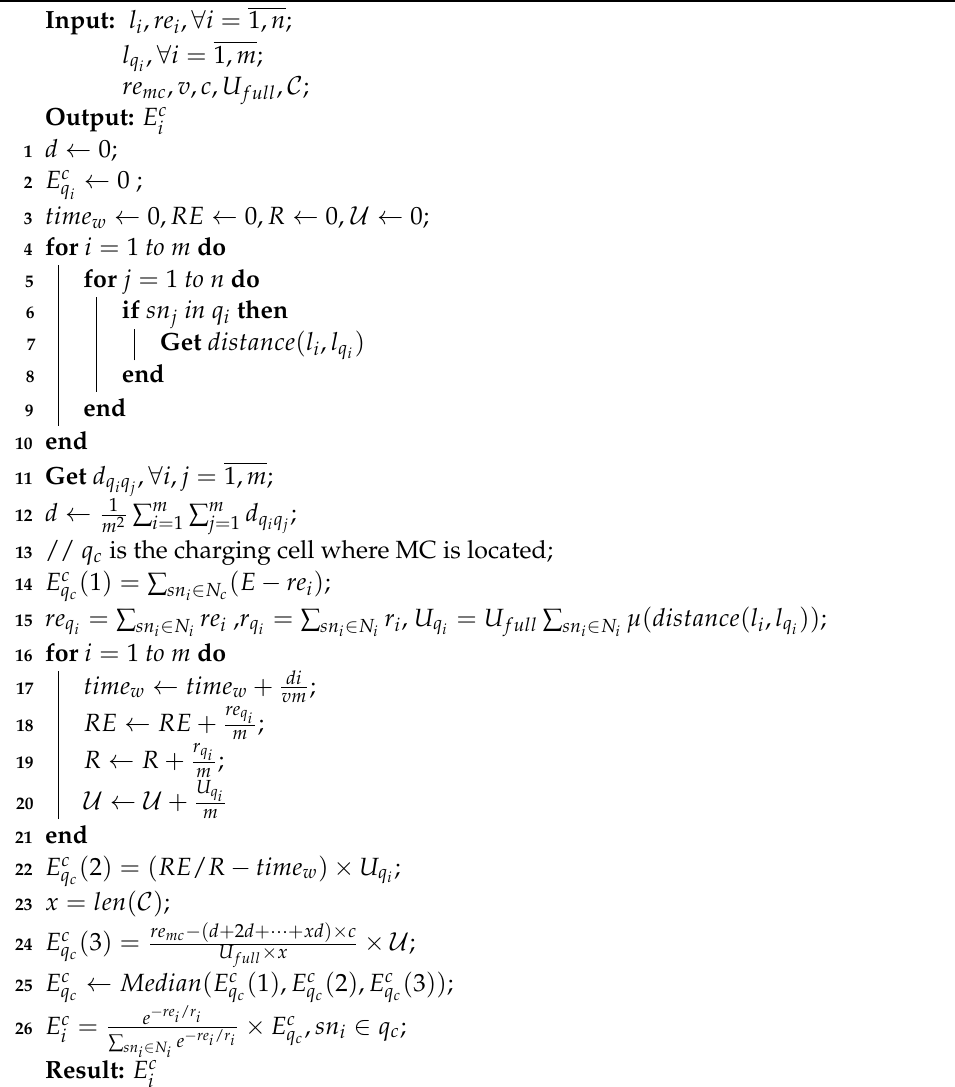
Algorithm 2: Charging amount of nodes